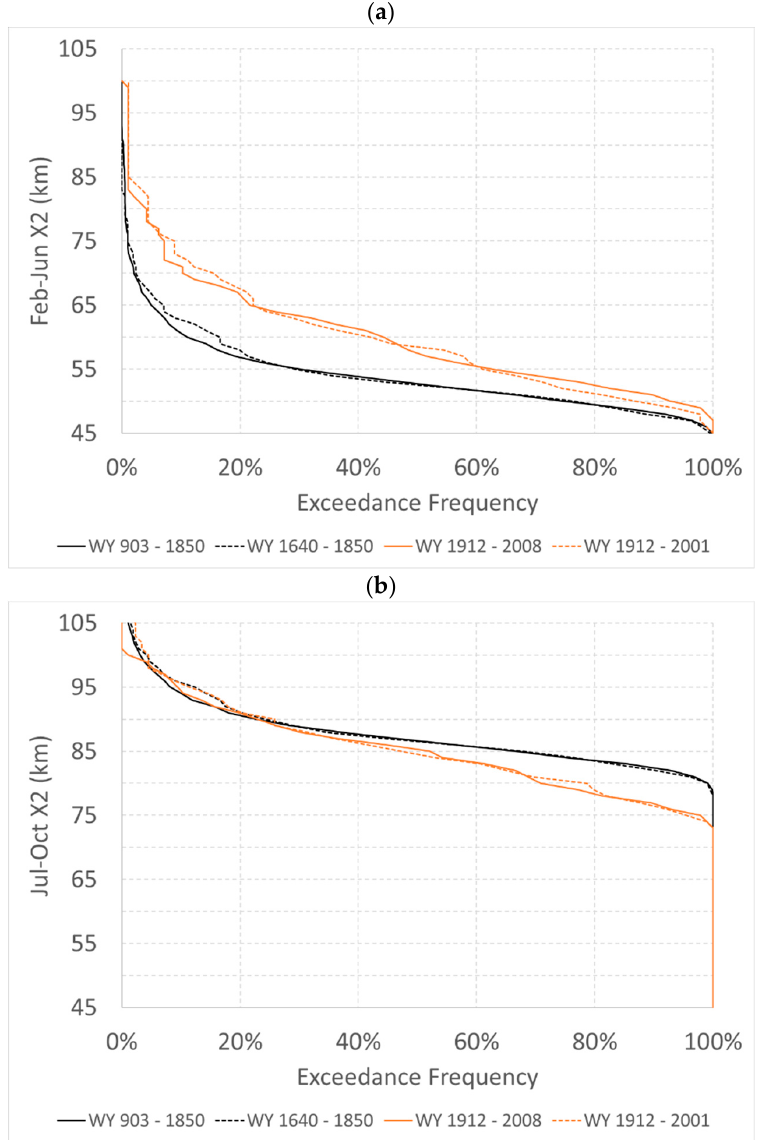
Figure 11. Reconstructed seasonal X2 exceedance frequency under pre-development (Model 2) and contemporary (Model 3) conditions. Feb–Jun and Jul–Oct X2 exceedance curves are shown in ( a ) and ( b ), respectively. Exceedance curves are provided for long and short record